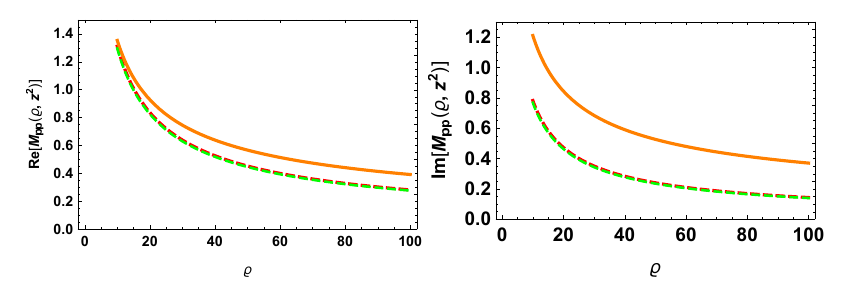
Figure 2. In the left panel, the orange curve is the numerical evaluation of the real part of eq. (10) (all twist resummed by BFKL), the green dashed curve is the real part of the LT term only, while the red dashed one is the real part of LT + NLT result. In the left panel we plot the imaginary parts. The range of ̺ is from 10 to 100.